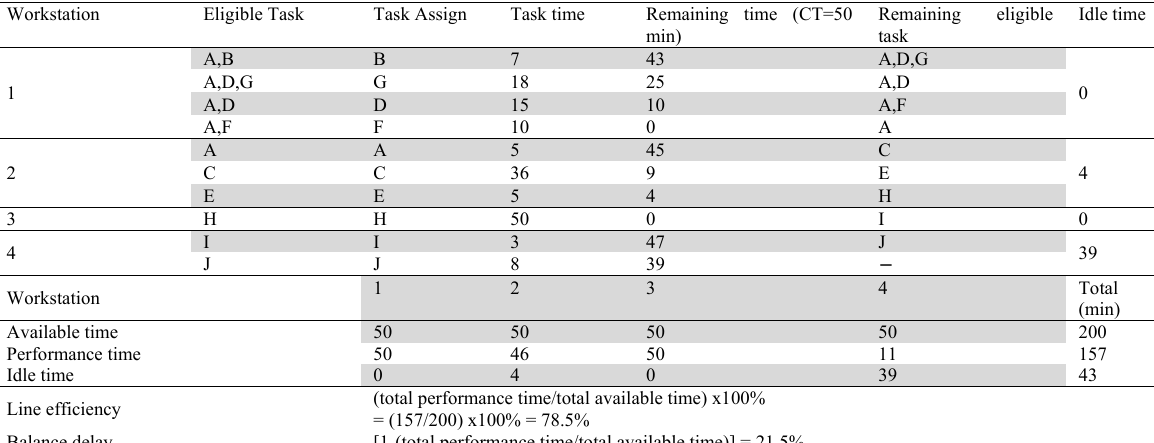
Modified allocation of activities into various